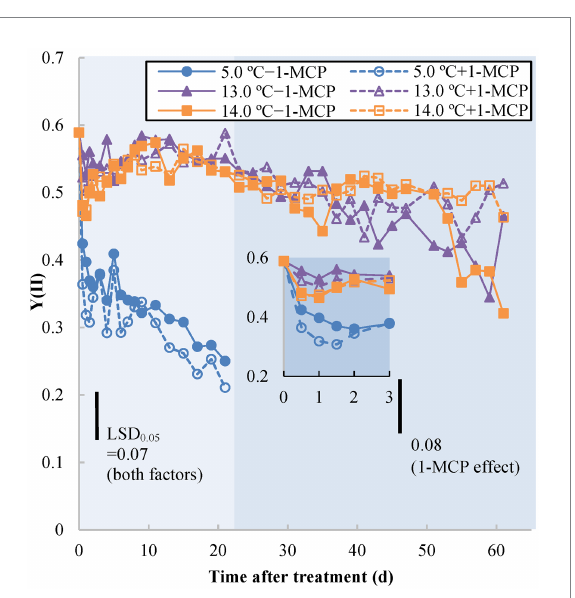
FIGURE 1 Photochemical efficiency as measured by light-adapted status photosystem II chlorophyll fluorescence quantum yield [Yield (II)] of banana peel initially treated with 0 ( − 1-MCP) or 50 μ L L − 1 (+ 1-MCP) aqueous 1-MCP for 60 s at 23.0 ° C and transferred to 5.0, 13.0 or 14.0 ° C storage with 95% RH ( n = 3). LSD 0.05 values varied within different time frames shown by different background shading (days 0–21; days 23–61) due to the various shelf-life durations of